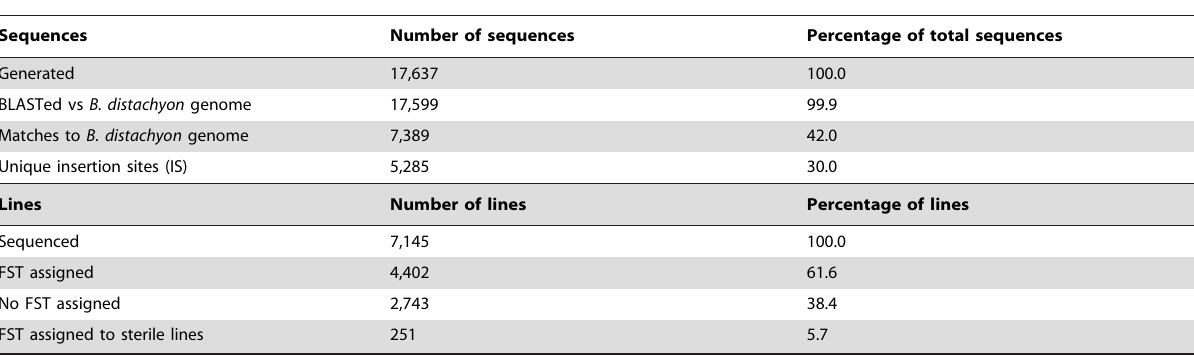
Table 4. Flanking sequence tags (FSTs) generated for T-DNA lines.